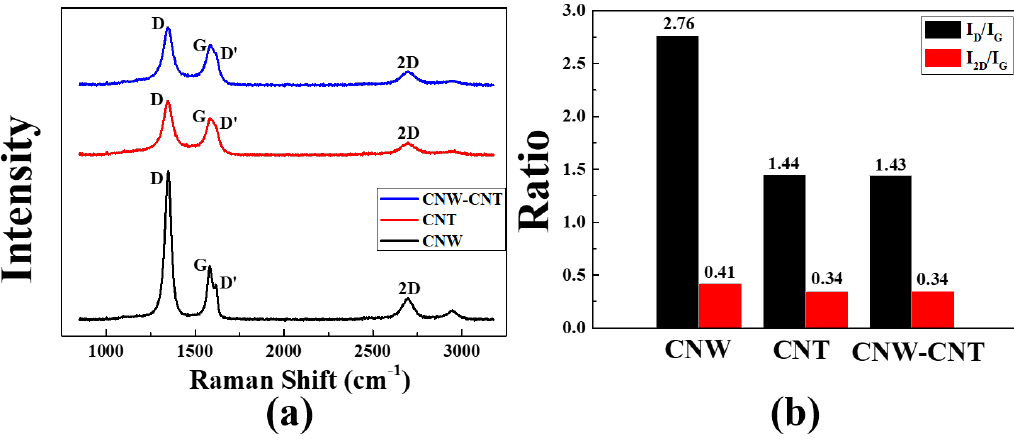
Figure 4. ( a ) The Rama shift of the CNW (black line), CNT (red line), and composite material with CNW and CNT (blue line). ( b ) The I D /I G and I 2D /I G ratio of CNW, CNT and composite material from Raman shift.